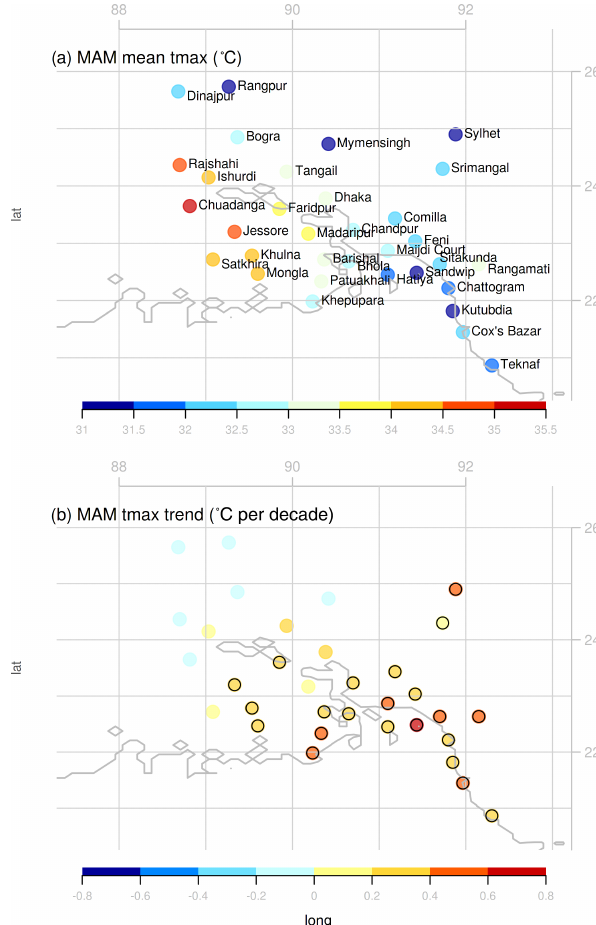
Figure 3. (a) Pre-monsoon (March–May) seasonal mean of the daily maximum temperature at different stations in Bangladesh, and (b) the trend in daily maximum temperature, based on observations from 1981–2019. The black circles around the markers in (b) indi- cate that the trend is statistically significant at the 99% level ( p val- ues <